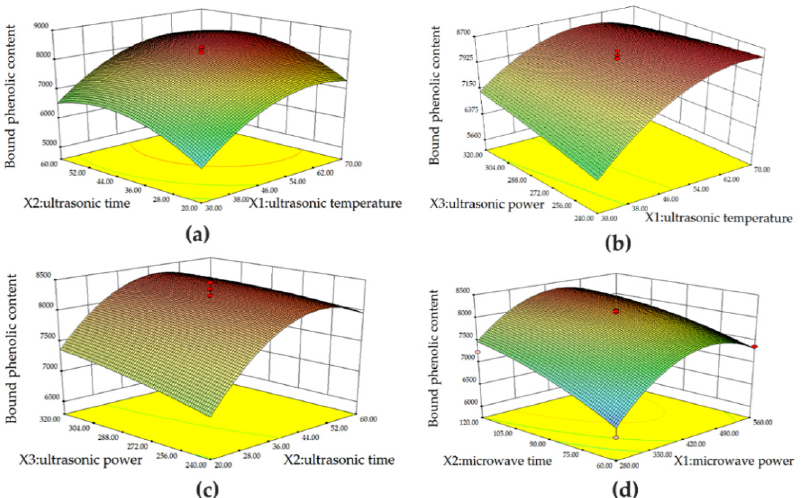
Figure 2. Graphical analysis of the effects of ultrasonic temperature (X 1 , ◦ C) and ultrasonic time (X 2 , min) ( a ); ultrasonic temperature (X 1 , ◦ C) and ultrasonic power (X 3 , W) ( b ); ultrasonic time (X 2 , min) and ultrasonic power (X 3 , W) ( c ); and microwave power (X 1 , W) and microwave time (X 2 , s) ( d ) on TBPCs ( µ g